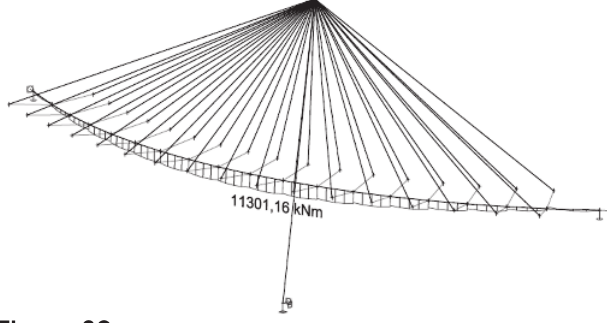
Bending moment on curved deck (P): bilateral case